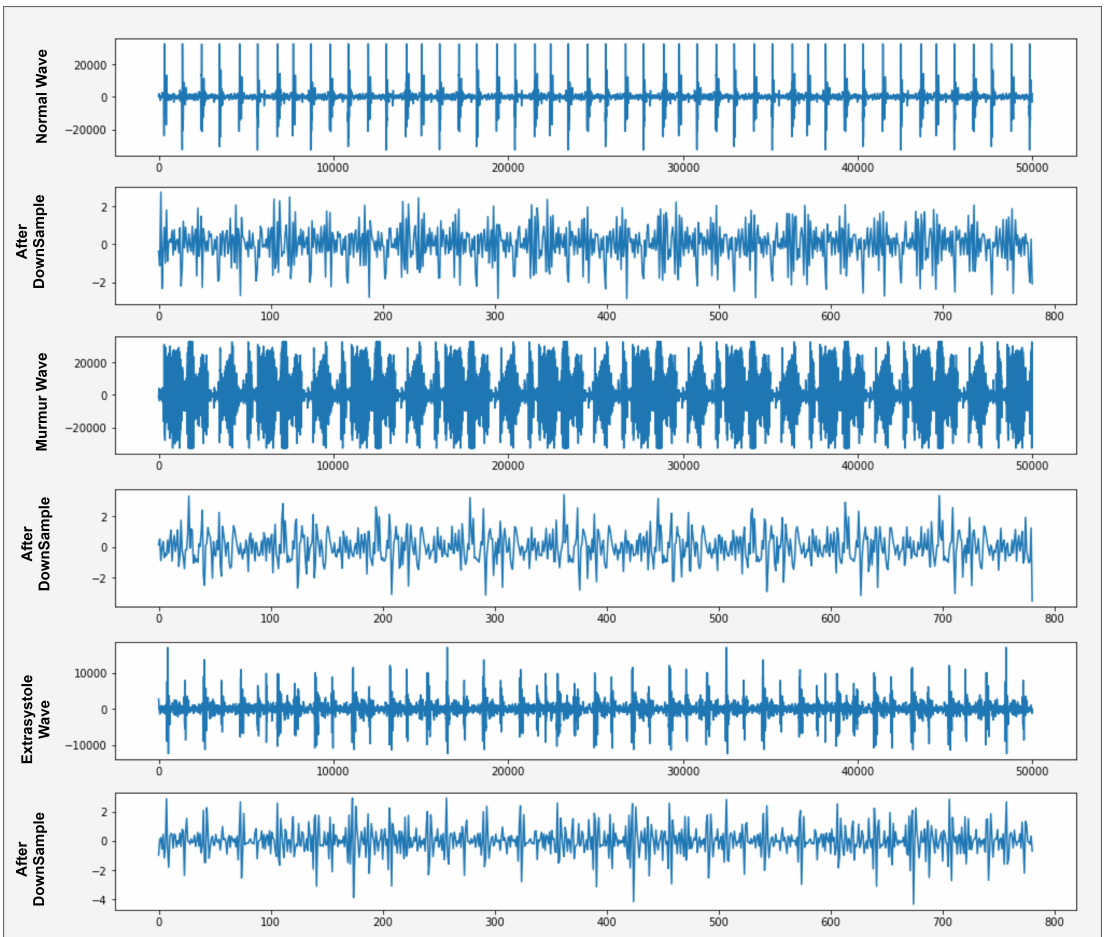
Figure 6. Graphical representation of Down-sampling Heartbeat sound signal.